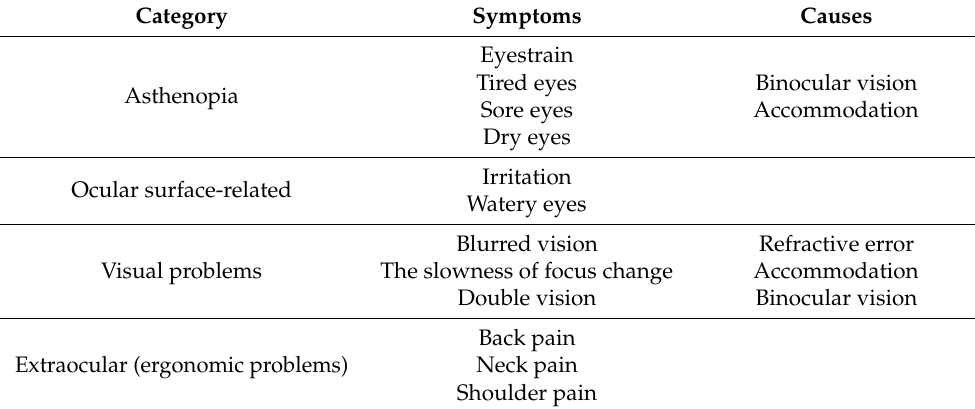
Table 1. Symptoms related to CVS (adapted from Blehm et al. [16]).